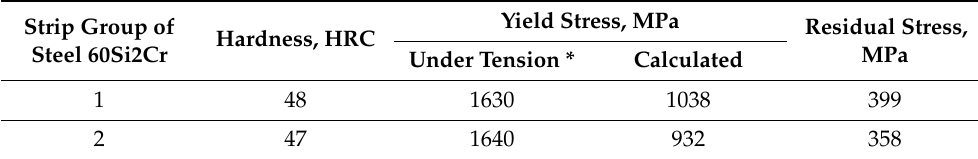
Table 3. Characteristics of strips from steel 60Si2Cr. Strip Group of Steel 60Si2Cr